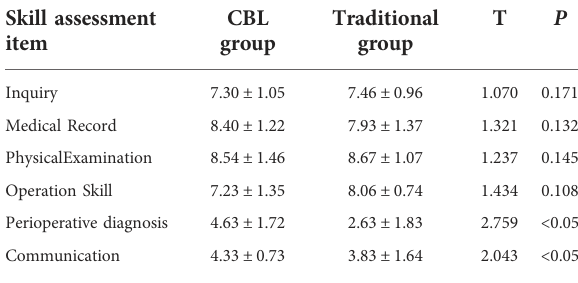
TABLE 3 Skill assessment item results.